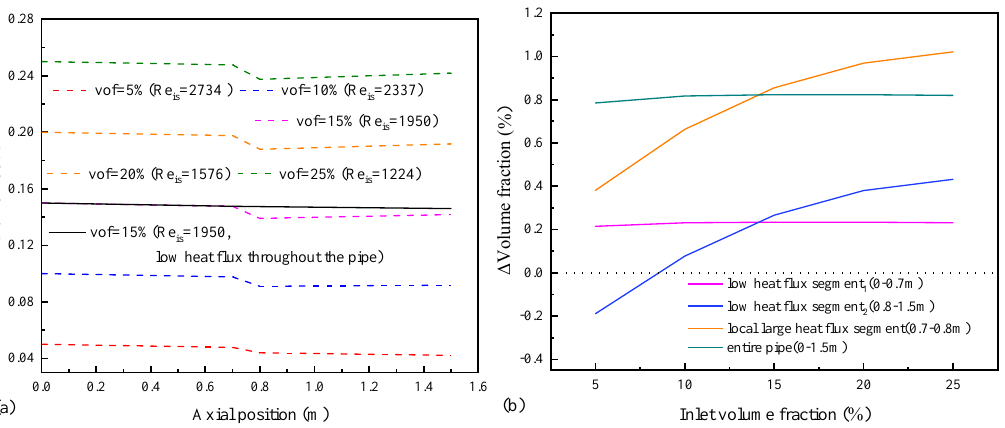
Figure 10. ( a ) Axial evolution of IVF with different inlet IVF ( b ) ∆ IVF of each segment with different inlet IVF.